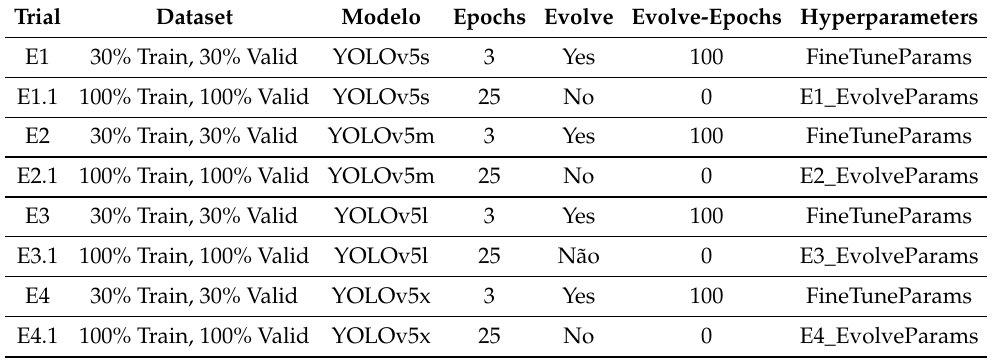
Table 5. Tests performed using four object detection algorithms selected for mask detection task.